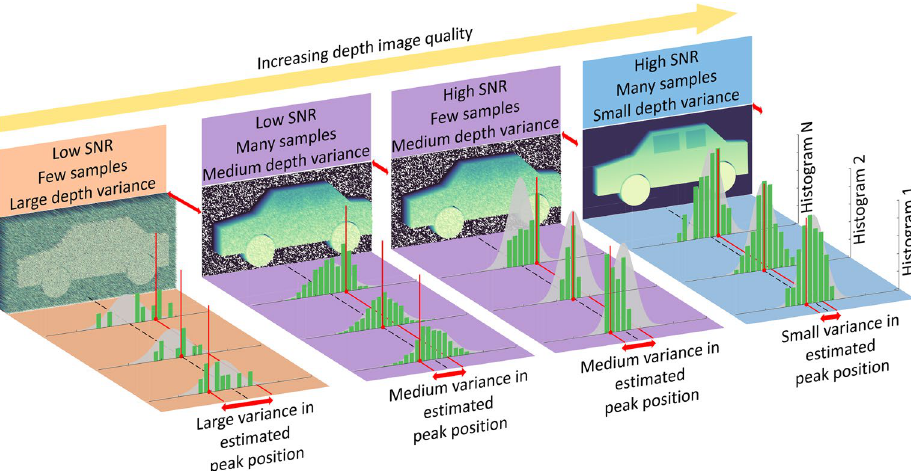
Figure 2. A conceptual illustration of the relationship between the variance in the estimate of the peak position of the histograms and the obtained depth image. Two Signal to Background-Noise Ratio (SbNR) and two sampling cases are depicted for a total of four regimes. Within each regime the underlying probability distribution of photon arrivals is shown by the grey curve. This curve is consistently centered on the true depth value shown by the black dashed line. The grey curve is sampled to produce a series of histograms, as shown by the green bars. For each histogram, the vertical red line illustrates the estimated position of the peak i.e., the depth. The variance in the estimate of the peak position, around the true depth value, is depicted by the double- headed red arrows. When this variance is large due to low SbNR and sparse sampling, as shown in the left most regime, the distinguishability in the depth image is poor i.e., fine features cannot be seen. When the variance is reduced, either by denser sampling or, higher SbNR (middle two regimes), the quality of the depth image improves. Lastly, when the histogram position can be repeatedly accurately determined (high SbNR with dense sampling) the variance is small and fine features in the depth image can be